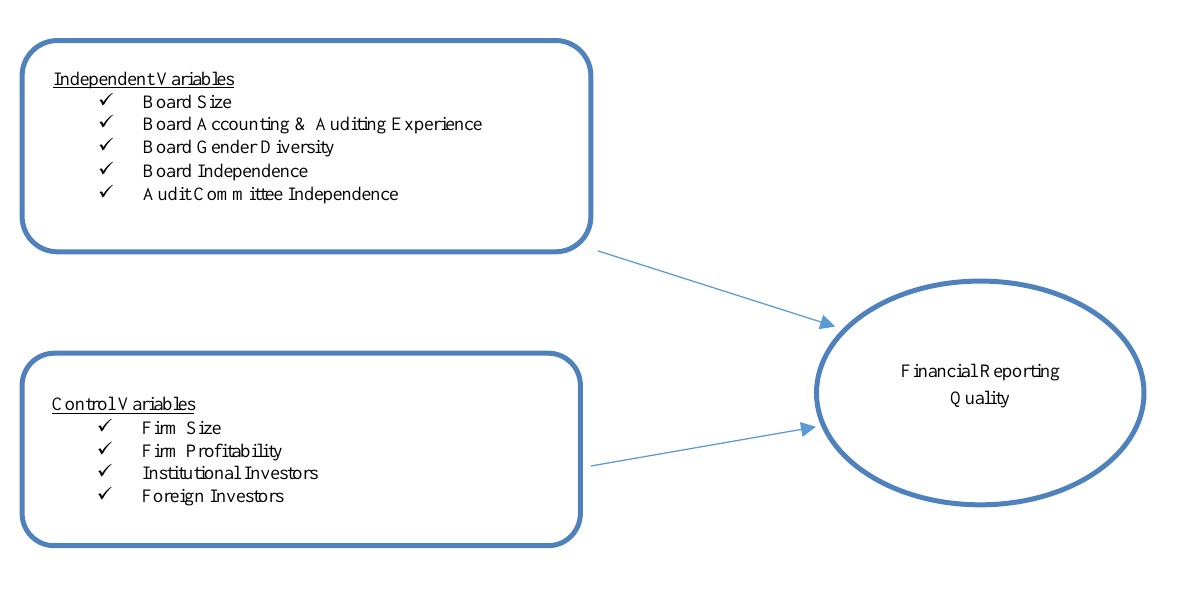
Figure 1: Conceptual Framework for Financial Reporting Quality; Source: